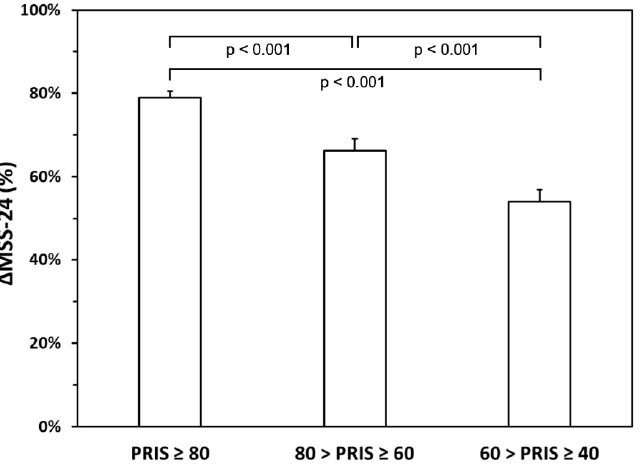
Figure 4. Stratification of patients in three groups according to the Predictive Response to Immunotherapy Score (PRIS) results and their ΔMSS-24. A significant difference was found between the three groups (F (2.97) = 16.32; p < 0.001).